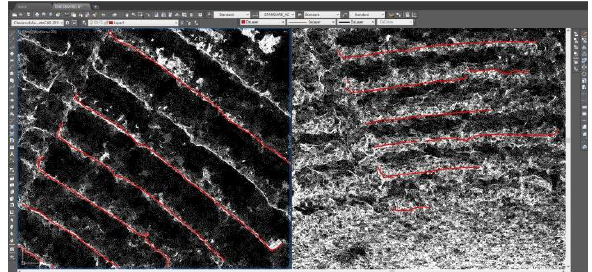
Figure 4 - Tracing of polylines on the cloud in CAD